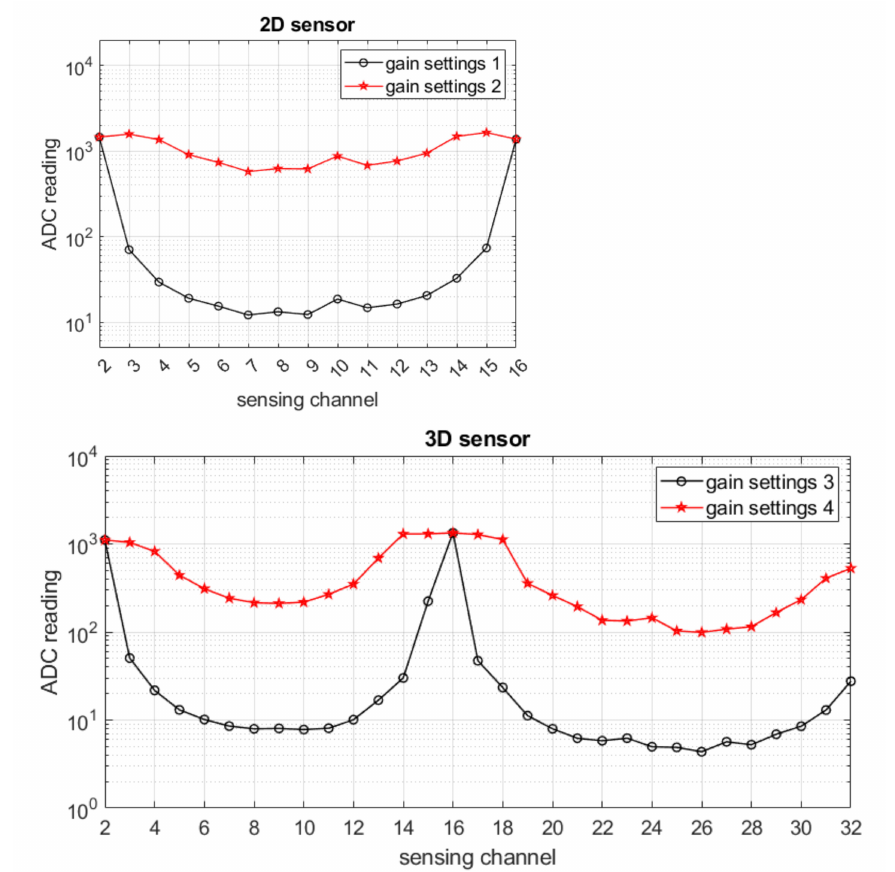
Figure 12. ADC readings in a sensing channel number (pair of electrodes) function at different gains. Measurement for 2D ( top ) and 3D sensor ( bottom ). The first channel is connected to an excitation electrode. All gains in settings 1 and 3 are equal to 0.162. The gains in settings 2 and 4 are equal to 7.407 except for the channels corresponding to the adjacent electrodes (0.162 for immediately adjacent electrodes; 3.704 for electrodes distant by two